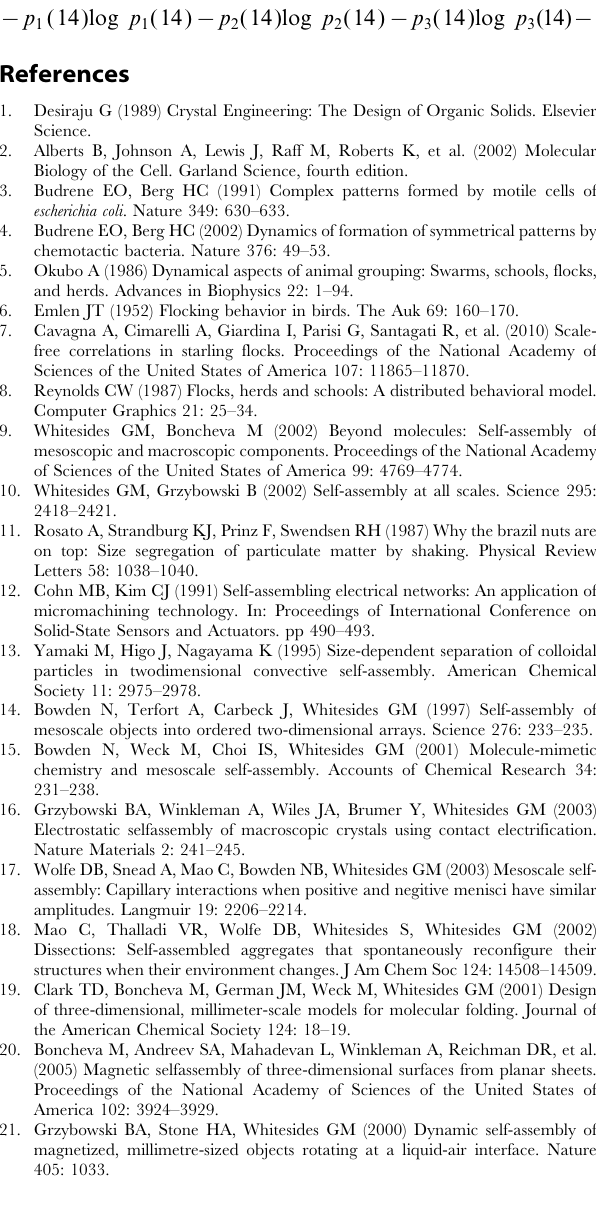
Video S1 Video showing typical segregation phenomena for circular, square, and triangular case. For each shape, active and passive elements are marked in red and green, respectively. The speed of the video is set eight times faster